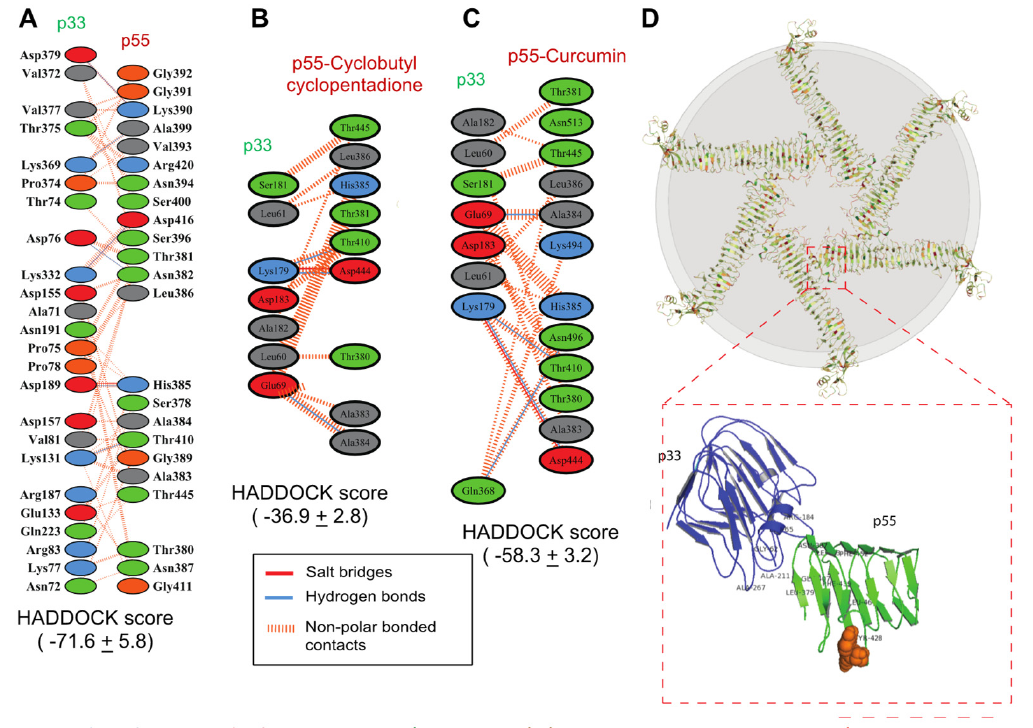
Figure 5. Effect of Cyclobutyl cyclopentadine and Curcumin on p33 and p55 docking interaction and vacA protein hexamer. ( A ) Schematic representation of binding interaction between the p33 and p55 domains of VacA protein. Amino acid residues involved in the interaction between p33 and p55 domains are shown in different colors based on their chemical structure. Different bonding interactions between amino acids are shown in different colors i.e., salt bridges, hydrogen bonds, etc. ( B ) Schematic representation of binding interaction between the p33 and p55-Cyclobutyl cyclopentadione complex. Amino acid residues involved in the interaction between p33 and p55-Cyclobutyl cyclopentadione complex are shown in different colors based on their chemical structure. Different bonding interactions between amino acids are shown in different colors i.e., salt bridges, hydrogen bonds, etc. ( C ) Schematic representation of binding interaction between the p33 and p55-curcumin complex. Amino acid residues involved in the interaction between p33 and p55-curcumin complex are shown in different colors based on their chemical structure. Different bonding interactions between amino acids are shown in different colors i.e., salt bridges, hydrogen bonds, etc. ( D ) A blueprint of VacA protein hexamer formed by VacA protomers. p33 (blue colored) and p55 (green colored) domains involved in hexamer formation.